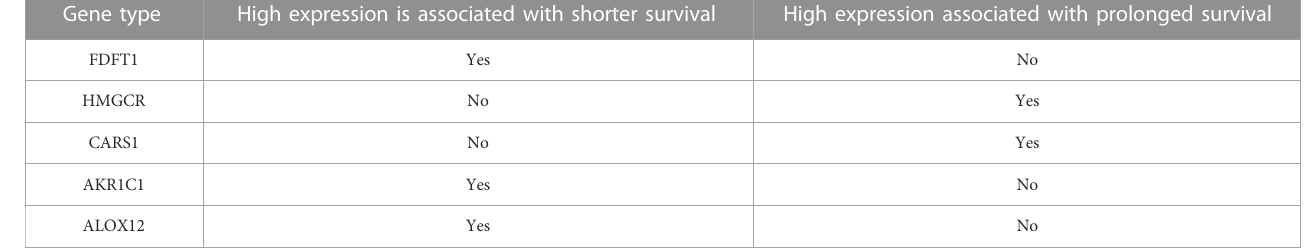
TABLE 2 Prognostic value of colon cancer genes. Gene type